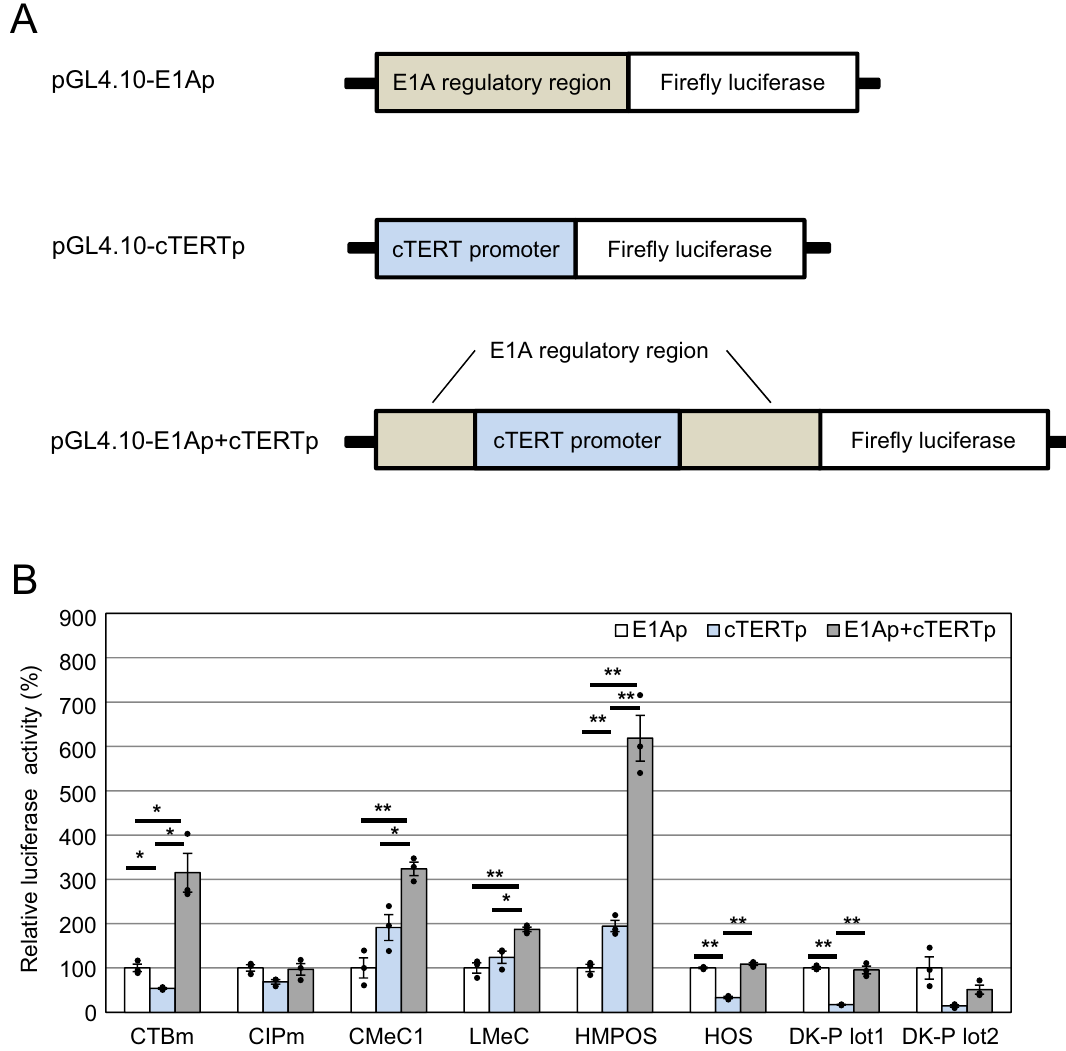
Figure 4. Luciferase reporter assay in various canine tumor cells and normal canine cells. ( A ) Schematic representation of the constructs. Mm32-E1A regulatory region (E1Ap), canine telomerase reverse transcriptase promoter (cTERTp), or the chimeric promoter (E1Ap + cTERTp) was cloned into pGL4.10 [luc2]. The resultant plasmids were named pGL4.10-E1Ap, pGL4.10-cTERTp, and pGL4.10-E1Ap + cTERTp, respectively. ( B ) Transcriptional activity of the E1Ap, cTERTp, and E1Ap + cTERTp. The construct with each promoter was transfected into canine tumor cells (CTBm, CIPm, CMeC1, LMeC, HMPOS, and HOS cells) and normal canine cells (DK-P lot1 and DK-P lot2 cells). At 24 h post-transfection, cell lysates were subjected to the dual-luciferase assay. Relative promoter activities are shown as the ratio of firefly luciferase to Renilla luciferase (an internal control) activity, and normalized to E1Ap activity. Data are presented as the mean values with standard errors of the mean for three independent experiments (with scatter plot of three values). The asterisks indicate significant differences (*p < 0.05; **p < 0.01 by Holm